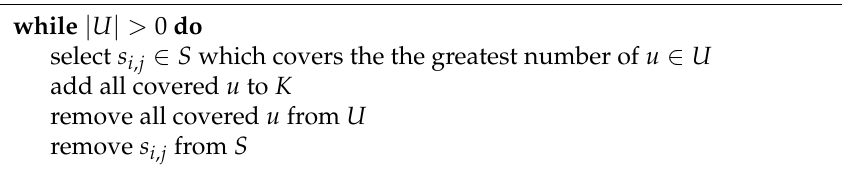
Algorithm 1 Greedy by Covering